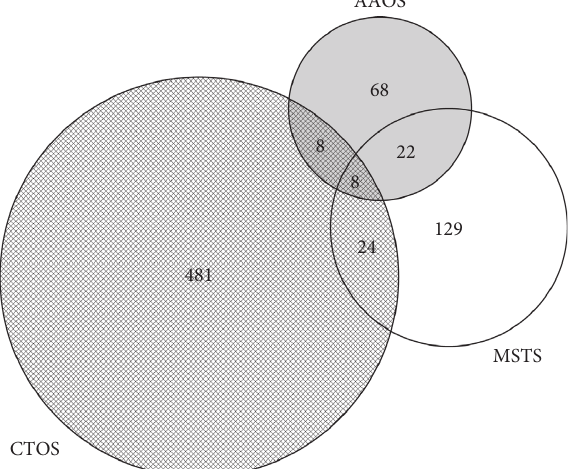
Figure 2: Overlap of published oncology abstracts presented at select AAOS, CTOS, and MSTS annual meetings. Depicted is an area-proportional Venn diagram, where the number of unique abstracts in each set is proportional to both the area of the circle and overlap. The number of unique abstracts in each set is also shown in the text. AAOS indicates the American Academy of Orthopaedic Surgeons; CTOS, Connective Tissue Oncology Society; MSTS, Musculoskeletal Tumor